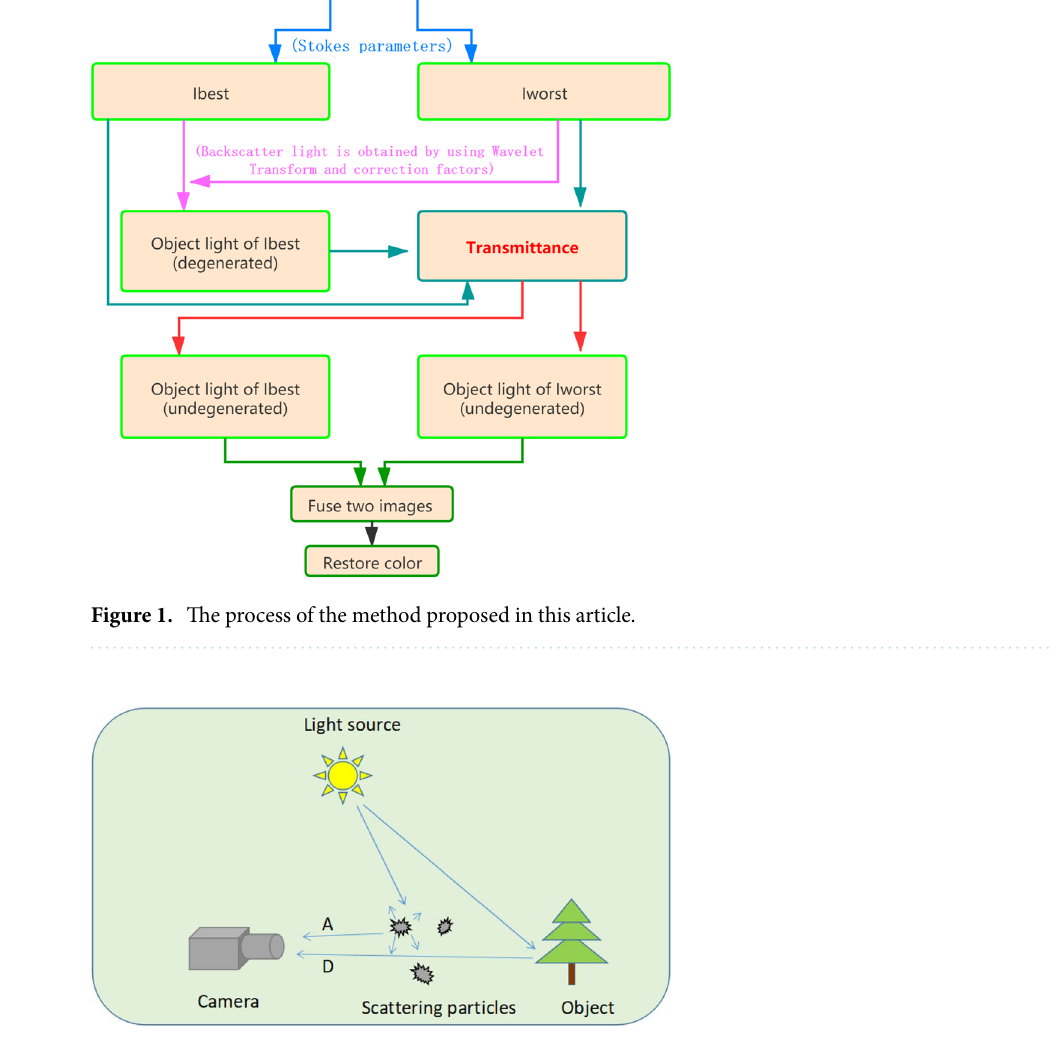
Figure 2. Imaging through a scattering